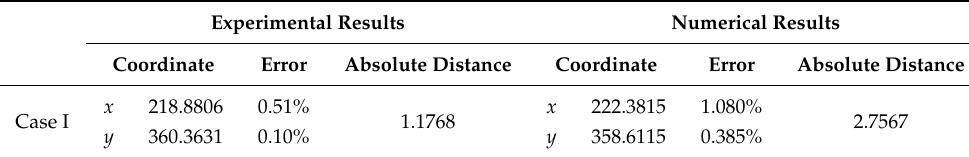
Table 10. Experimental and simulation results of two groups of 4 sensors under Case I.